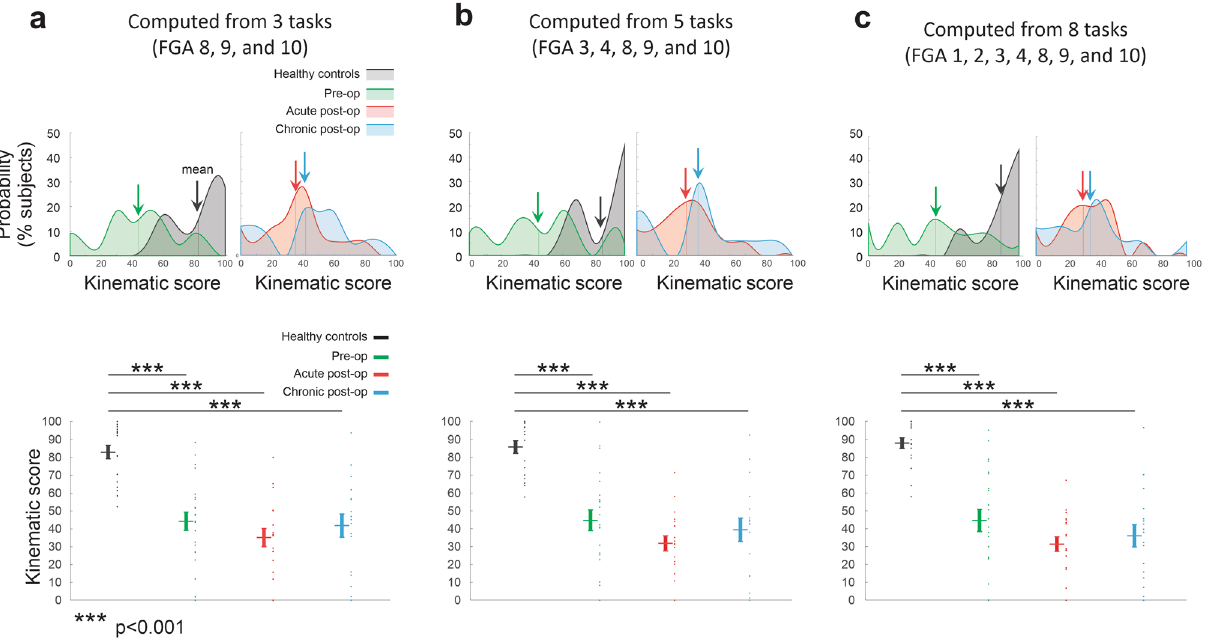
Figure 7. Comparison kinematic scores computed for (a) the 3 most challenging FGA tasks (FGA 8, 9, and 10), (b) 5 FGA tasks for which significant differences were typically observed between patients and controls (FGA 3, 4, 8, 9, and 10), and (c) across all 8 tasks for which gait cycles were extracted (FGA 1–4, 8, 9, and 10). (a-c) Top-left: Probability distributions of the kinematic scores computed for healthy controls (black), pre-op patients (green). Arrows indicate the average values. Top-right: Probability distributions of the kinematic scores computed for acute post-op (red), and chronic post-op patients (blue). Bottom: Comparison of the kinematic scores of healthy controls versus unilateral vestibular patients. Vertical lines correspond to mean ± SEM of the kinematic score for each group, while the kinematic score for individual subjects are illustrated as points. Asterisks denote significant difference between healthy controls and patients (*** p <